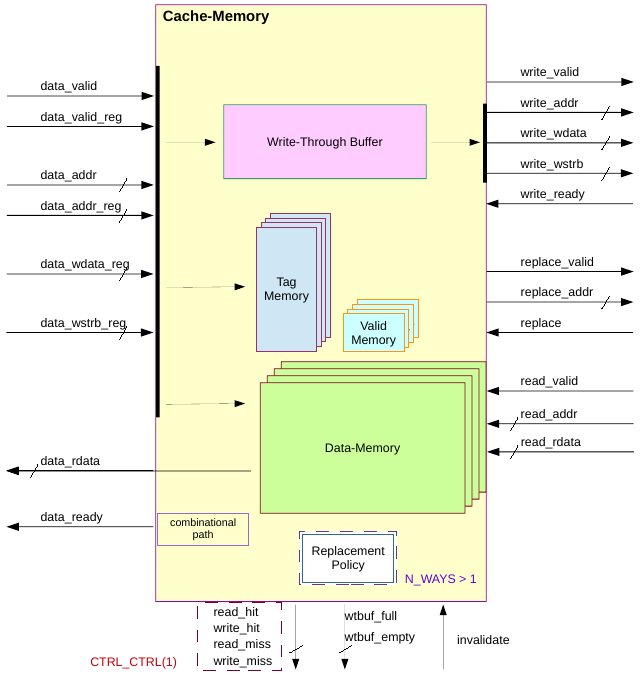
Figure 2. Cache-Memory module